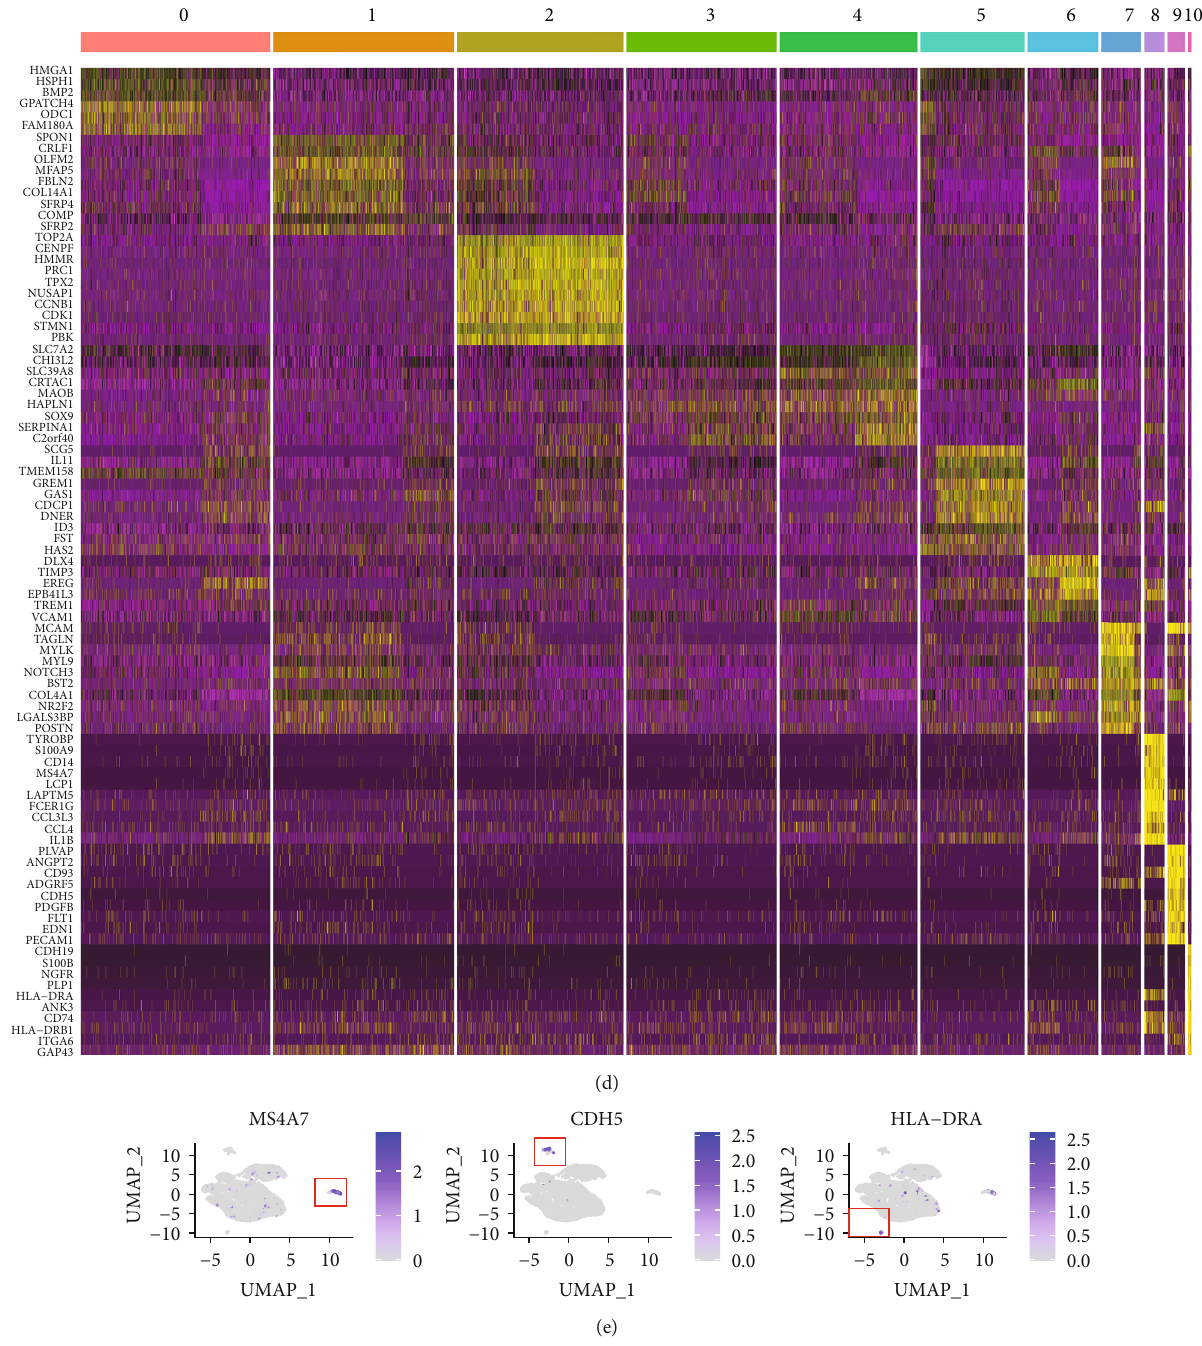
Figure 1: Single-cell RNA-seq analysis of cell types in the knee of healthy and OA patients. (a) UMAP plot of 6833 single cells from the human knee depicting 11 major cell types. Colours correspond to the clusters 0 to 10. (b) Bar plot shows frequency of each cell type in total, healthy, and OA groups. (c) Split UMAP plot depicting the clusters from healthy (N) and OA patients (O). (d) Heat map indicates the top 10 marker genes for each cell type. (e) Expression distribution of the top marker genes for the nonchondrocytes projected onto the UMAP plot: macrophages (MS4A7), endothelial cells (CDH5), and monocytes